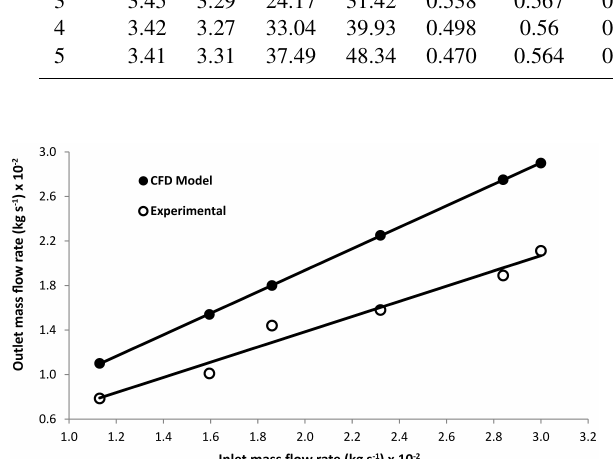
Figure 15. Validation of numerical model based on